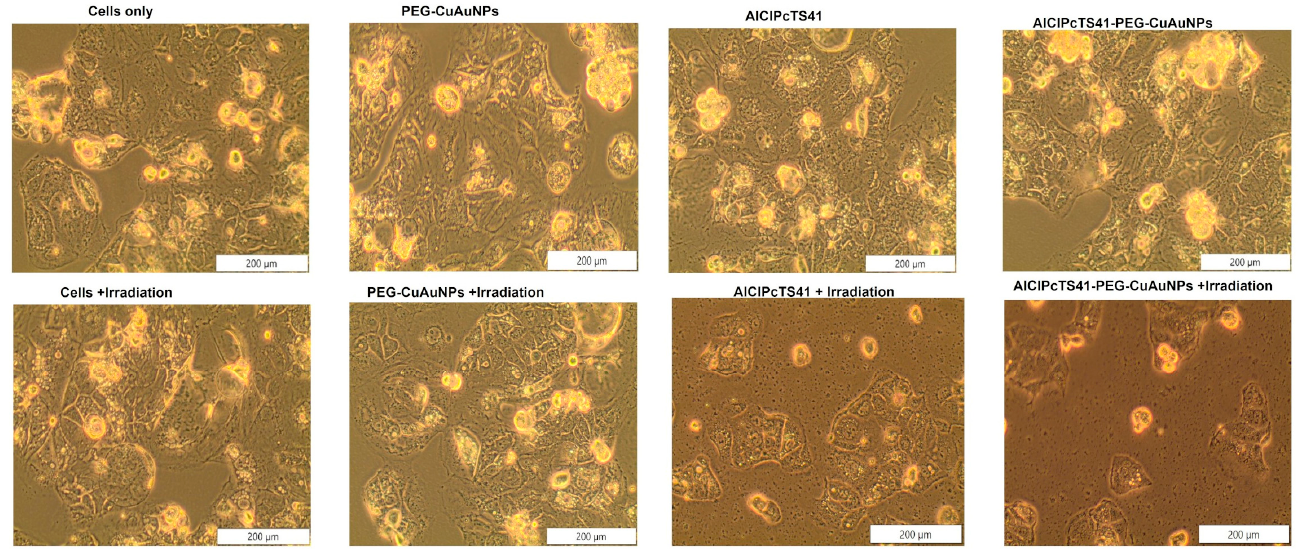
Figure 11. Cellular morphology of Caco-2 cells after AlClPcTS41, PEG-CuAuNPs, and AlClPcTS41- PEG-CuAuNPs-PDT-mediated treatments.